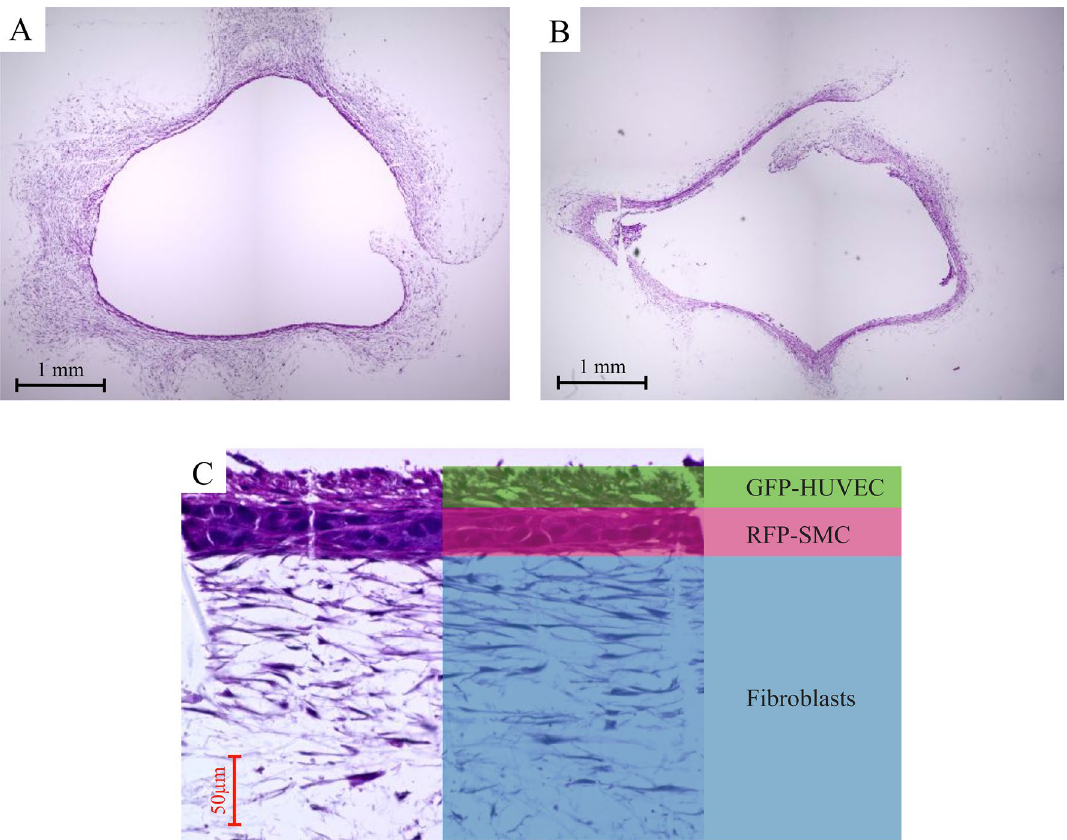
Figure 9. ( A ) Overview of a representative cross section of a 1 ml/min three-layered blood vessel stained by HE. ( B ) A 5 ml/min three-layered blood vessel. ( C ) Enlarged view of three layers. Example of thickness calculation of each cell layer.